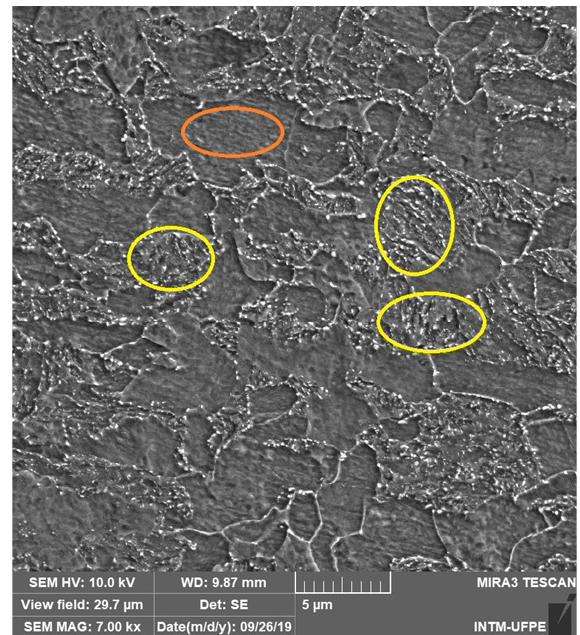
Figure 7. Microstructure of the material produced by the 580-15